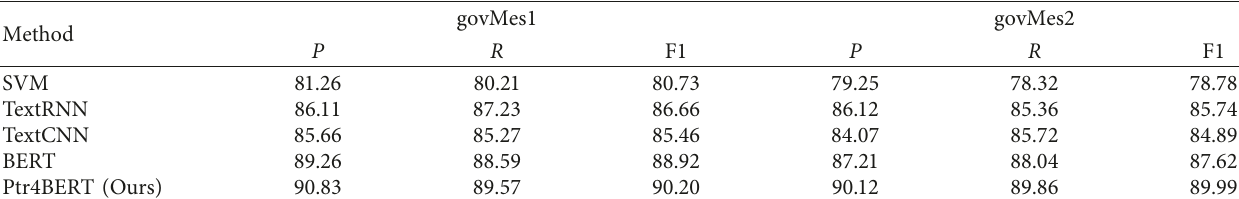
Table 5: Performance comparison of different methods in English